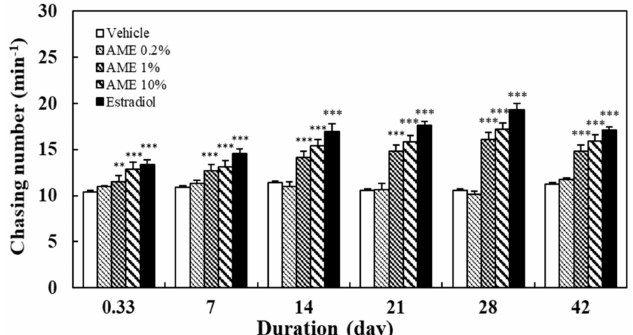
Figure 1. Effects of the supplementation with AME on the chasing number between the male and female zebrafish: Each dataset is represented by five independent repeated experiments. Statistical differences compared to the vehicle group were tested using one-way ANOVA. Levels of significance are expressed as ** p < 0.01 and *** p <